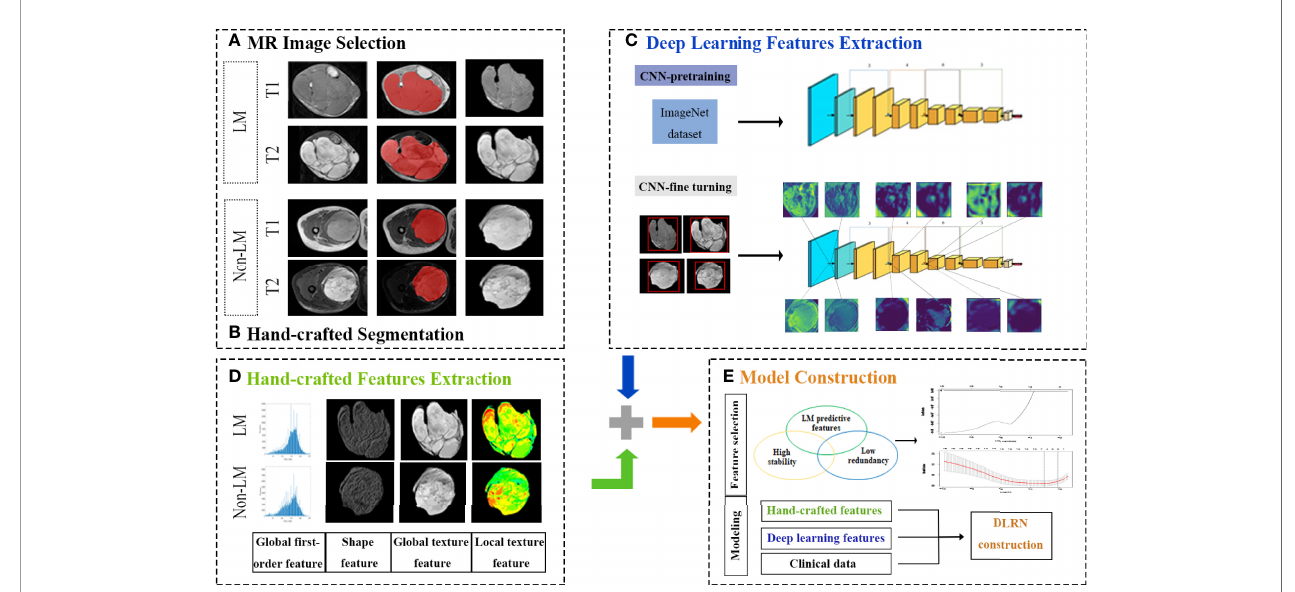
FIGURE 1 | Schematic of the radiomics